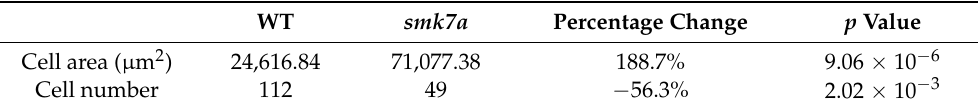
scale bar is 100 µ m. Comparison of the endosperm ( B ) cell area and ( C ) cell number between the WT and smk7a . The values are the means of the three replicates ± SD. Thirty cells were selected for statistical analysis for each replicate. ** denotes statistical significance at p < 0.01 according to the t -test. ( D ) Longitudinal section of the kernels collected from the WT and smk7a at 34 DAP. The red square indicates the region that was observed via scanning electron microscopy (SEM). The scale bar is 1 mm. ( E ) SEM analysis of the peripheral regions of the WT and smk7a endosperm collected at 34 DAP. The scale bar is 100 µ m. ( F ) SEM analysis of the starch granules of the WT and smk7a endosperm. SG, starch granule. The scale bar is 10 µ m. Table 1. Comparison of the endosperm cell area and cell number between the WT and smk7a in the same field of vision.